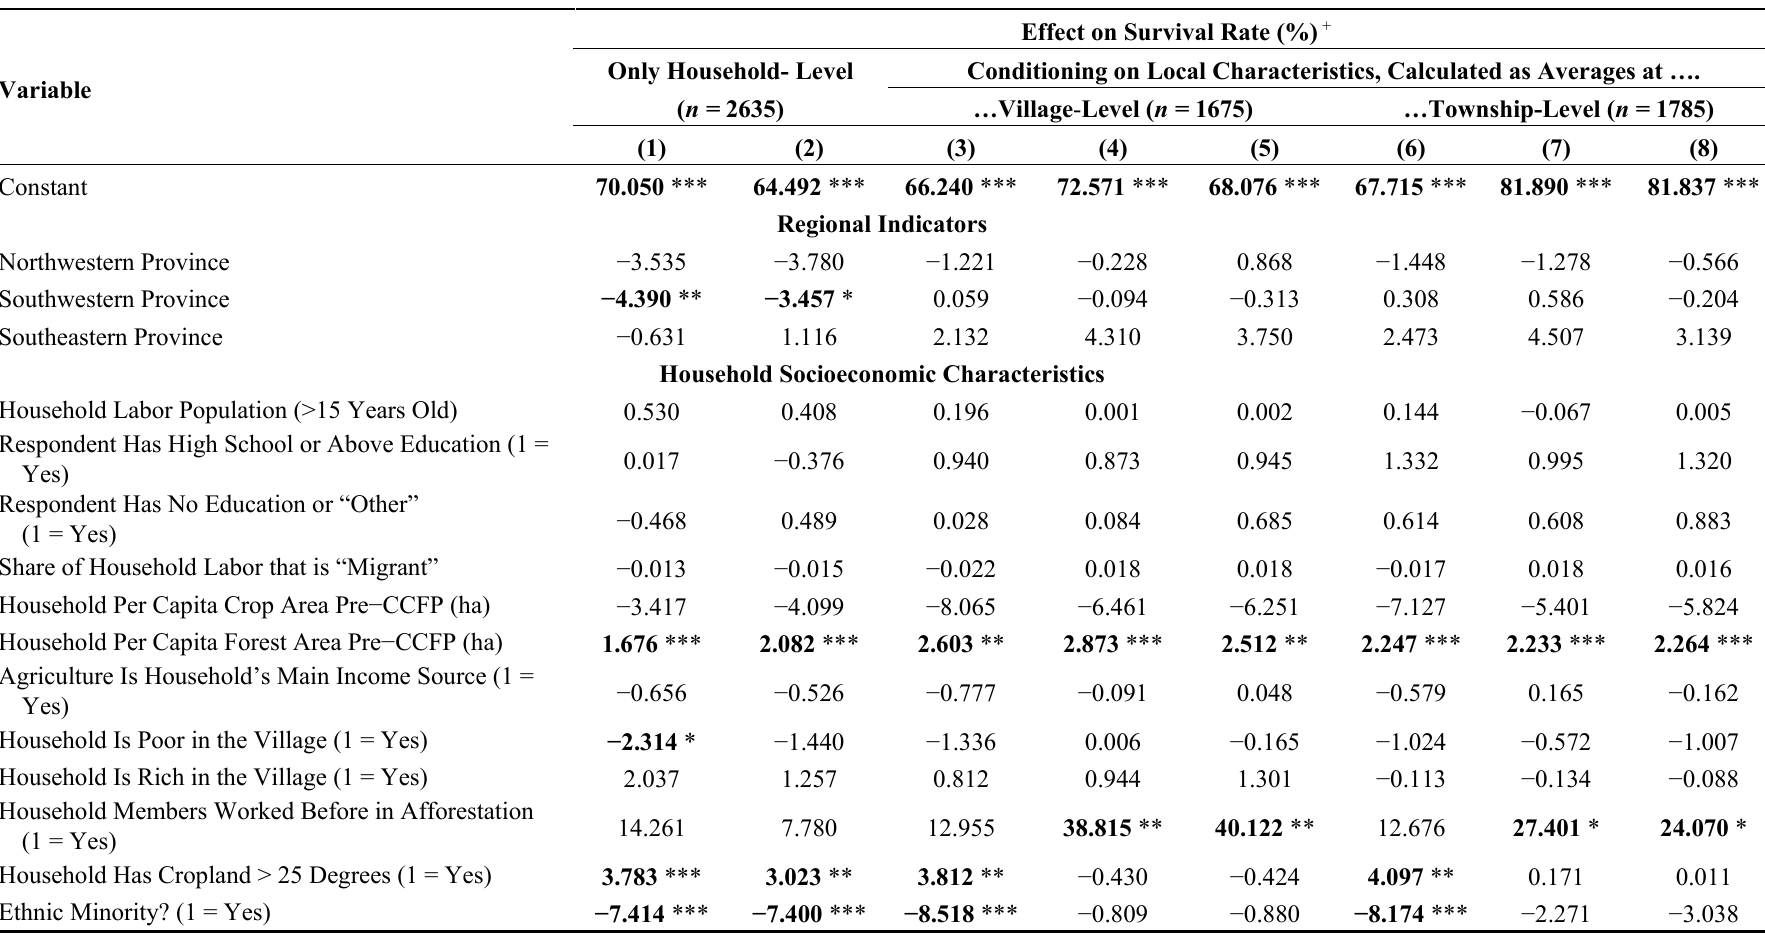
Conditioning on Local Characteristics, Calculated as Averages at